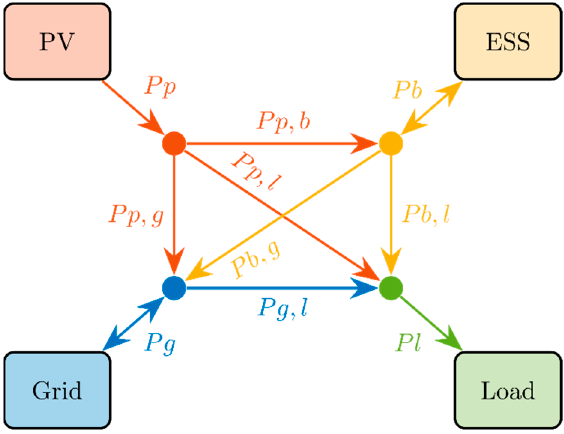
Table 1. Components size. Parameter